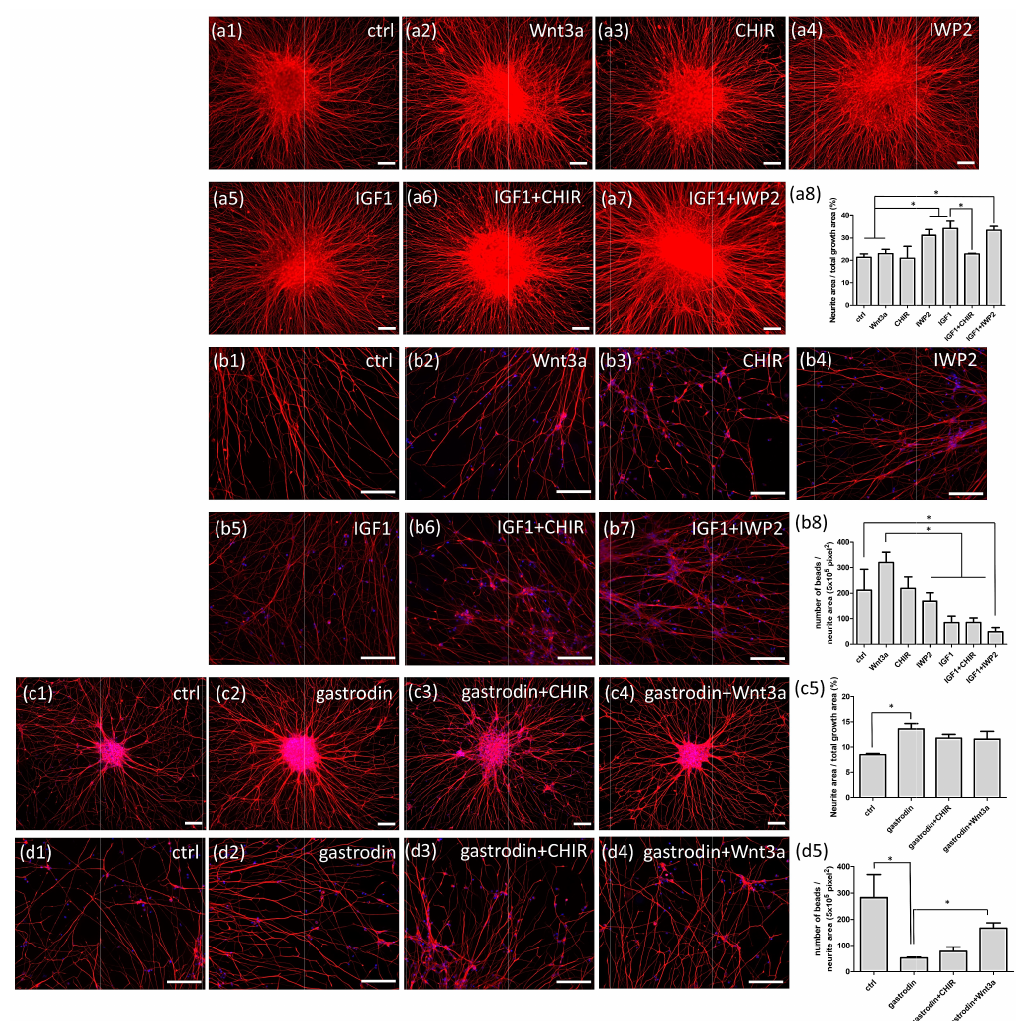
Figure 9. Activation of the GSK3 β and IGF-1 pathway reduces axonal cytopathies in SOD1 mutant ALS MNs. ( a ) Neurite densities of day-28 SOD1 G85R MNs treated with Wnt3a, CHIR99021, IWP-2, and IGF-1, and their combinations were analyzed with NF immunocytochemistry staining and calculated as ( a8 ). ( b ) Nerve fiber beads of day-35 SOD1 G85R MNs treated with the aforementioned compounds and their combinations were analyzed and calculated as ( b8 ). ( c ) Neurite density of day-28 SOD1 D90A MNs treated with gastrodin and its combinations with CHIR99021 or Wnt3a, were analyzed and calculated as ( c5 ). ( d ) Nerve fiber beads of day-35 SOD1 D90A MNs treated with gastrodin and combinations were analyzed and calculated as ( d5 ). * p < 0.05. Scale bar, 100 µ